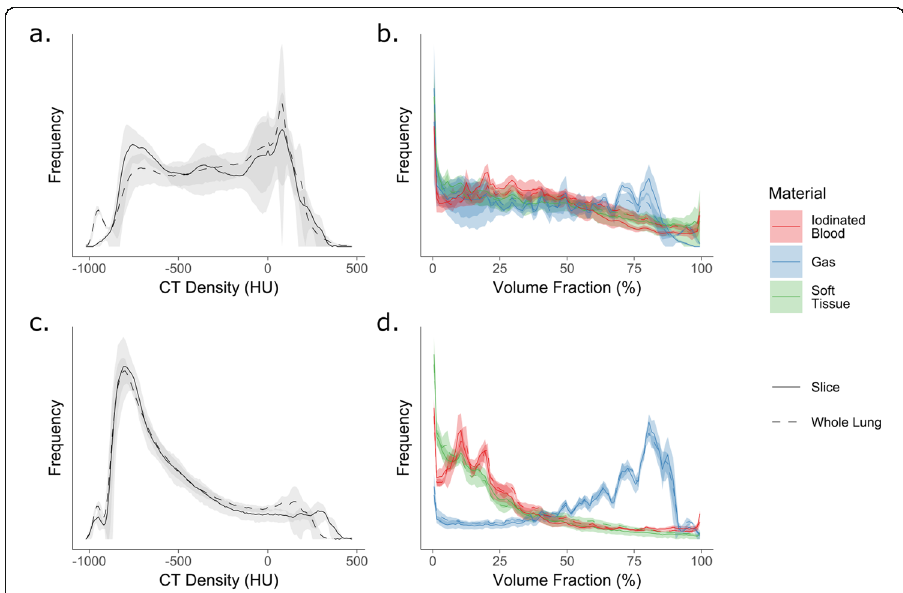
Fig. 3 Example distributions of CT densities ( a , c ) and those of the results of the three-material differentiation ( b , d ) between dynamic CT (solid line) and whole lung (dashed line). a , b PEEP 5 cmH 2 O, tidal volume 7 mL/kg, injured animals in expiration. c , d PEEP 12 cmH 2 O, tidal volume 15 mL/kg, uninjured animals in inspiration. There is an increased correlation between the two distributions in inspiration at higher PEEP and tidal volumes. Lines and shaded areas represent mean and standard deviations of n = 4 animals in each group